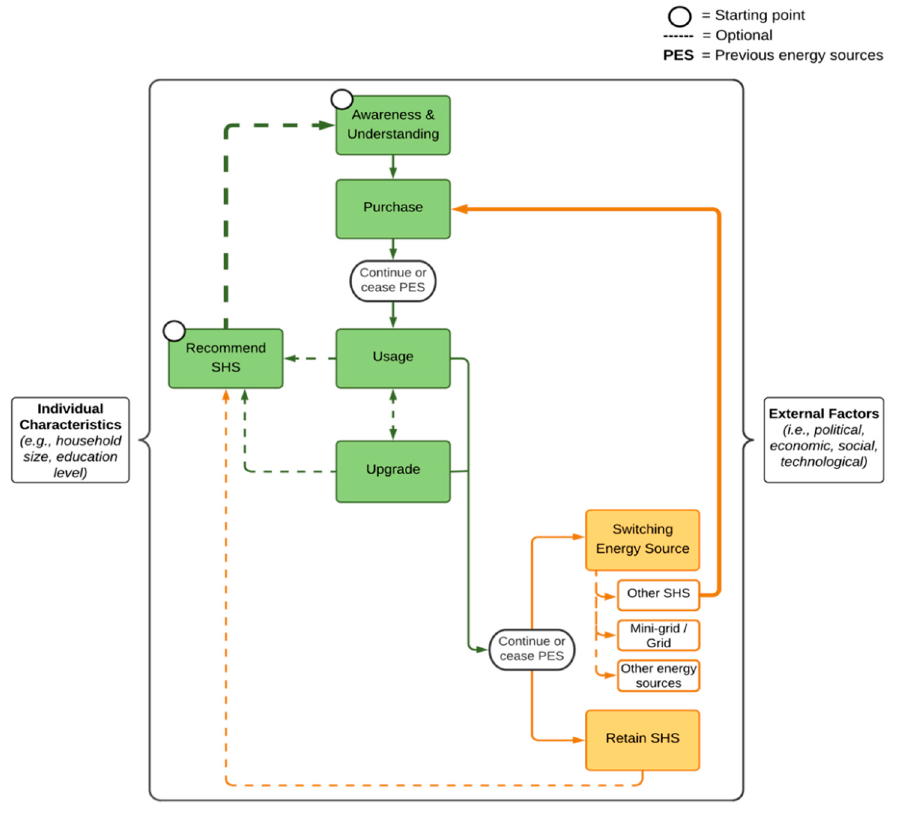
Figure 1. Pay-as-you-go solar home system (PAYG SHS) customer journey framework.